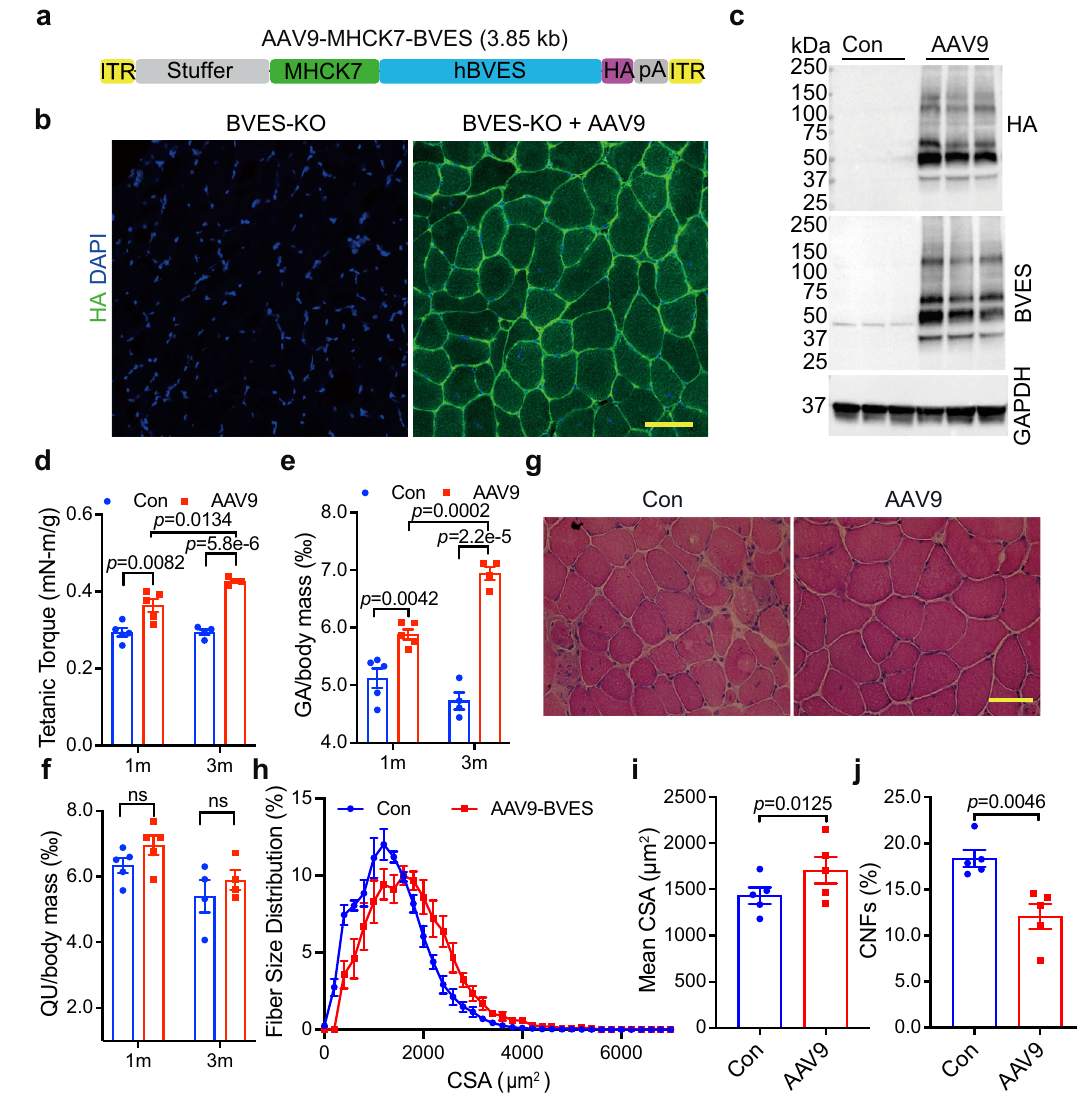
Fig. 3 | Muscle-speci fi c expression of BVES ameliorates skeletal muscle pathology in BVES-KO mice. All animal experiments were performed in BVES-KO malemicewiththeC57BL/6Ngeneticbackground. a SchematicmapofAAV9-BVES constructs. b Representative immuno fl uorescence images of AAV9-BVES treated and contralateral control GA muscles in BVES-KO male mice (5 months of age) stained with the antibody against HA-tag and DAPI. Scale bar: 100 µ m. ( n =6 per treatment). c WesternblotofBVESexpressiondetectedwithanti-BVESandanti-HA antibodiesinAAV9-BVEStreatedandcontralateralcontrolGAmuscles(5monthsof age). d Tetanic torque measurements of the posterior compartment muscles of AAV9-BVES treated and contralateral control GA muscles at 1 ( n =5 for Con and AAV9-BVES) and 3 ( n =4 for Con and AAV9-BVES) months after injection. e , f The relative mass of AAV9-BVES treated and contralateral control GA muscles ( e ) or untreated QU muscle ( f ) normalized by the body weight at 1 ( n =5 for Con and